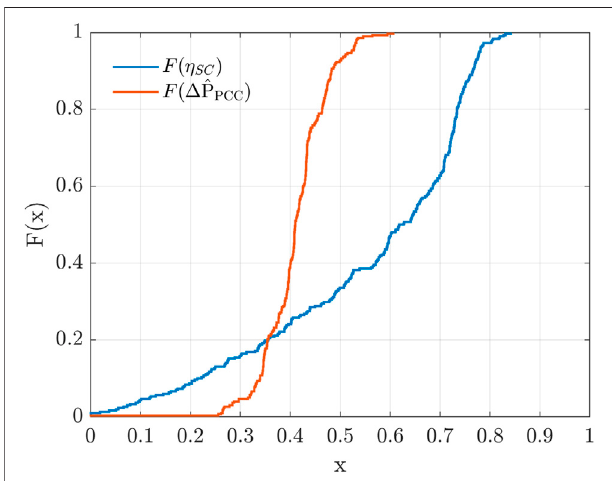
FIGURE5| Cumulativedistributionassessmentoftheself-consumption η SC (blue trace) and the normalized peak power increment over a 1-year